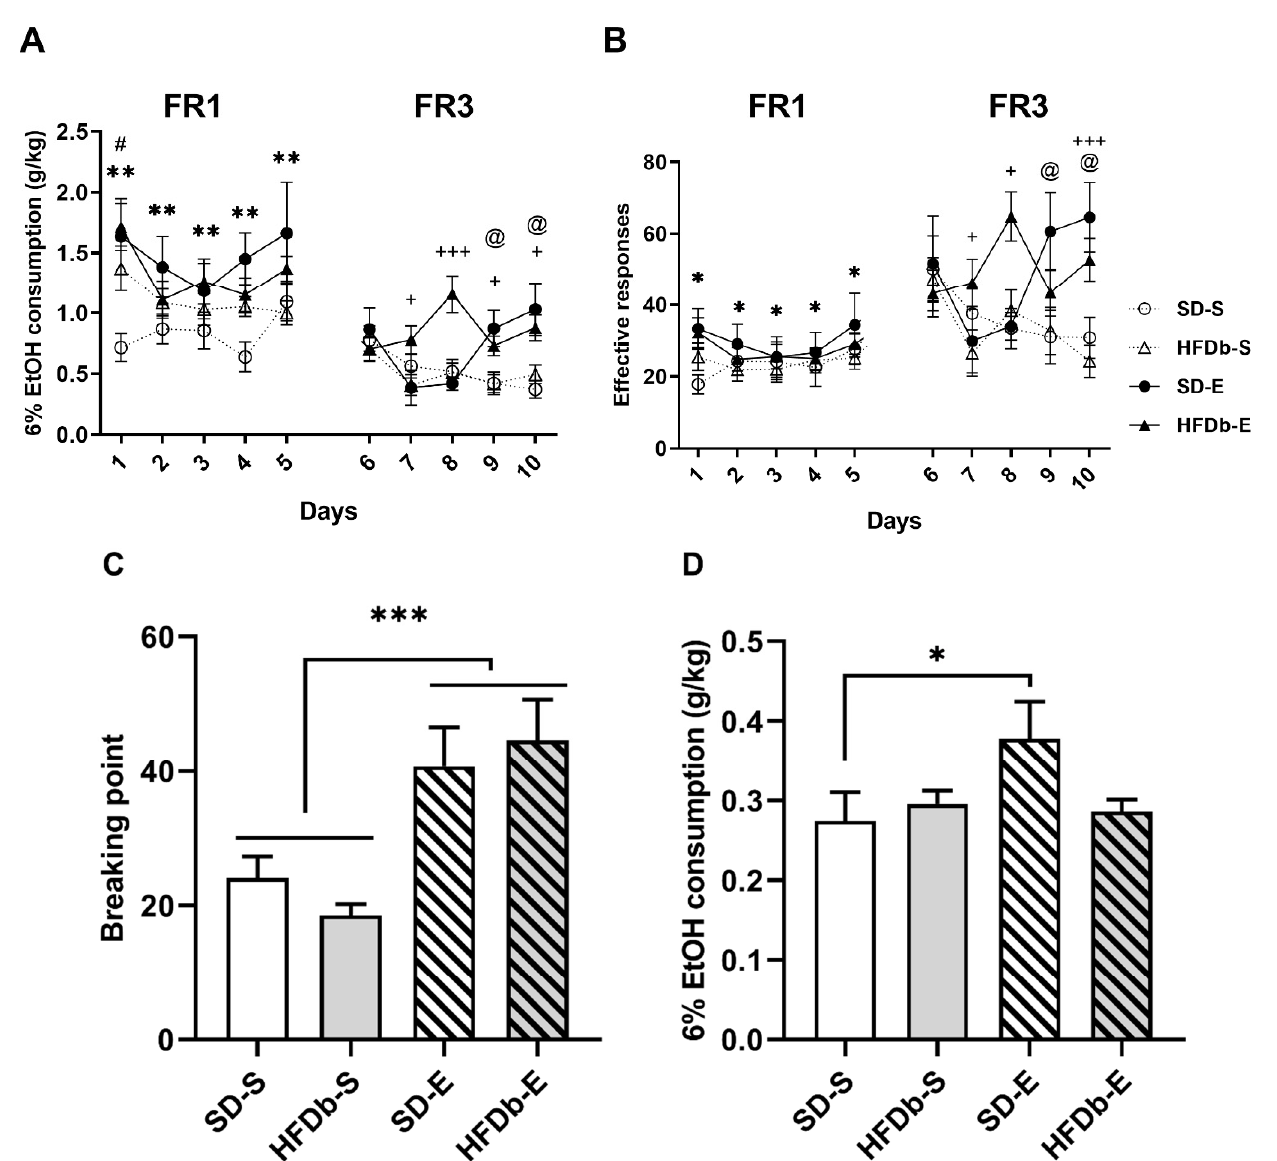
Figure 5. Effects of intermittent high-fat diet (HFD) bingeing on effective responses and oral ethanol EtOH self- administration in OF1 mice. Data are presented as mean ( ± SEM): ( A ) g/kg of 6% EtOH consumption and ( B ) the number of effective responses during FR1 and FR3. The columns represent means and the vertical lines ± SEM of ( C ) breaking point values during PR and ( D ) amount of 6% EtOH consumption during the PR session. * p < 0.05; ** p < 0.01; *** p < 0.001 values that are significantly different from animals that received BD compared to the saline groups. + p < 0.05; +++ p < 0.001 significant differences in the HFDb-E compared to the HFD-S group. @ p < 0.05 significant differences in SD-E group with respect to SD-S. # p < 0.05 significant differences in the HFDb group between Day 1 compared to Day 2, 3 and 4.